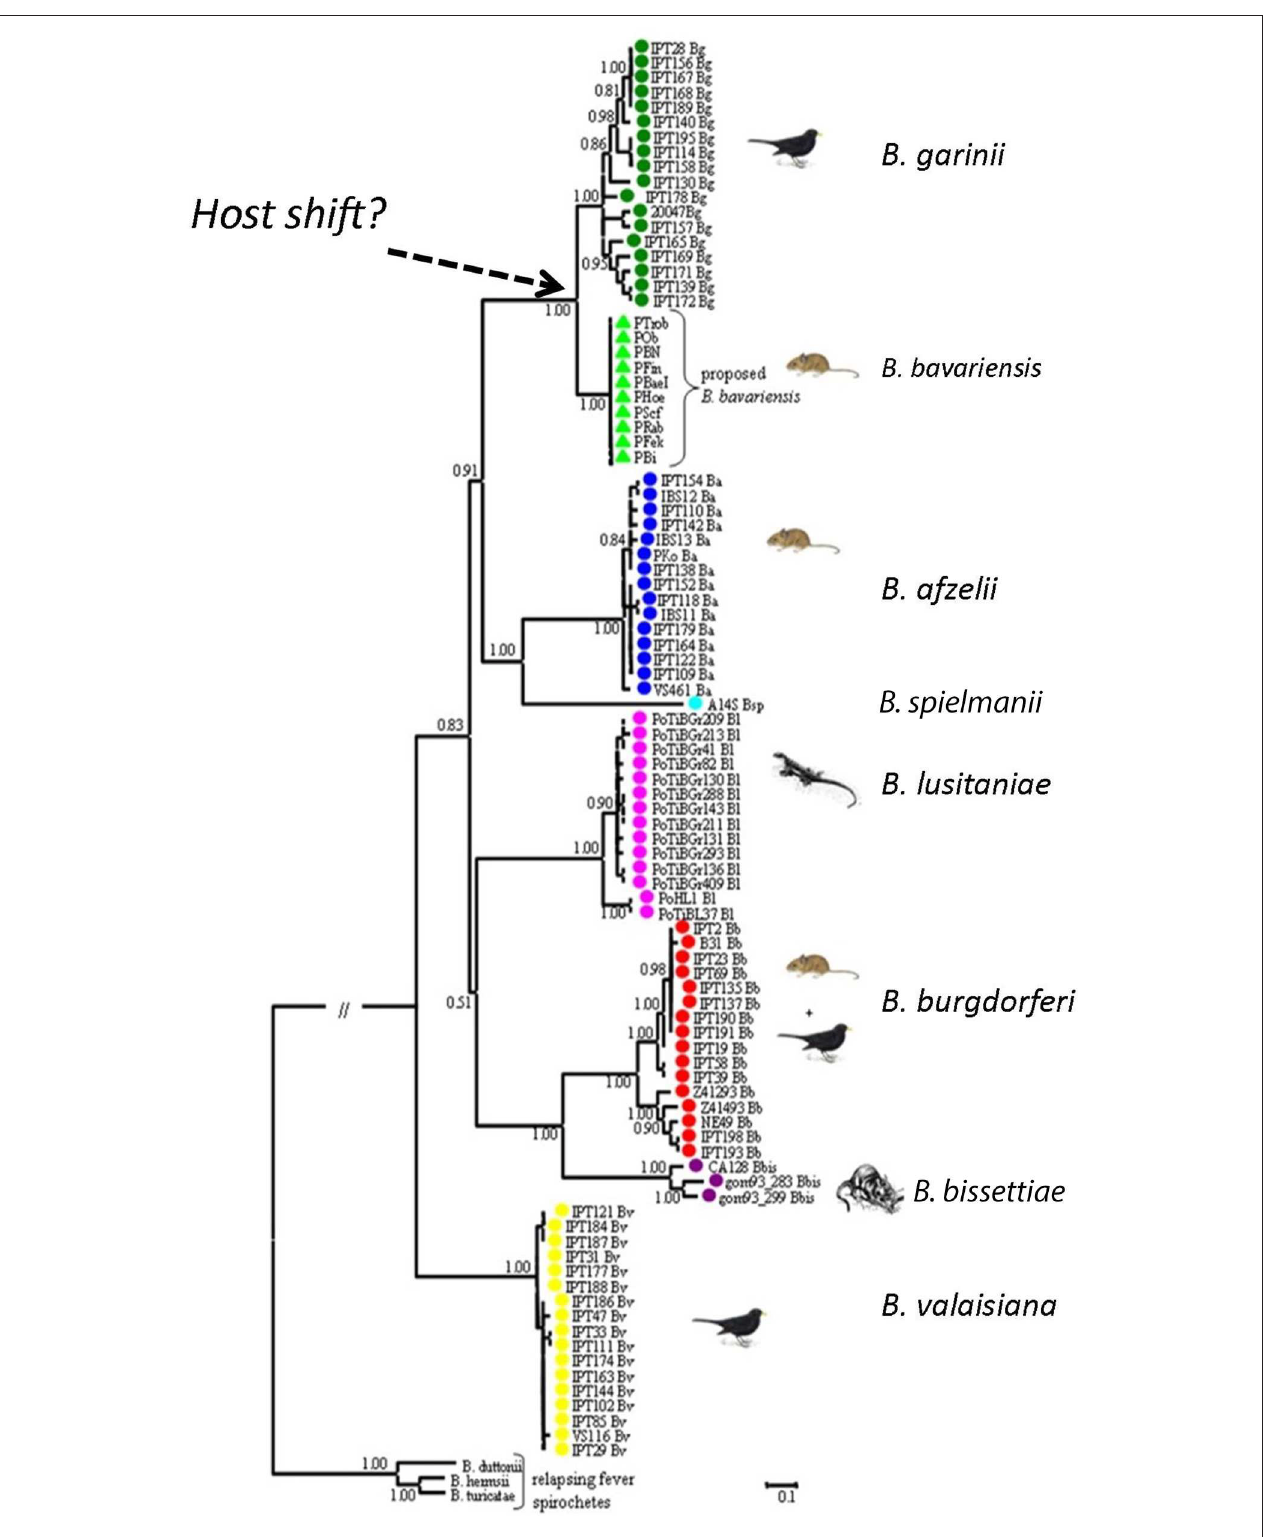
FIGURE 3 | Phylogenetic relationship of Borrelia genospecies. The phylogeny was generated using concatenated sequences of MLST housekeeping genes. Borrelia bavariensis is closest related and forms a sister clade to B. garinii . With permission from Margos et al. (2009), Applied and Environmental Microbiology 75, 5410–5416.